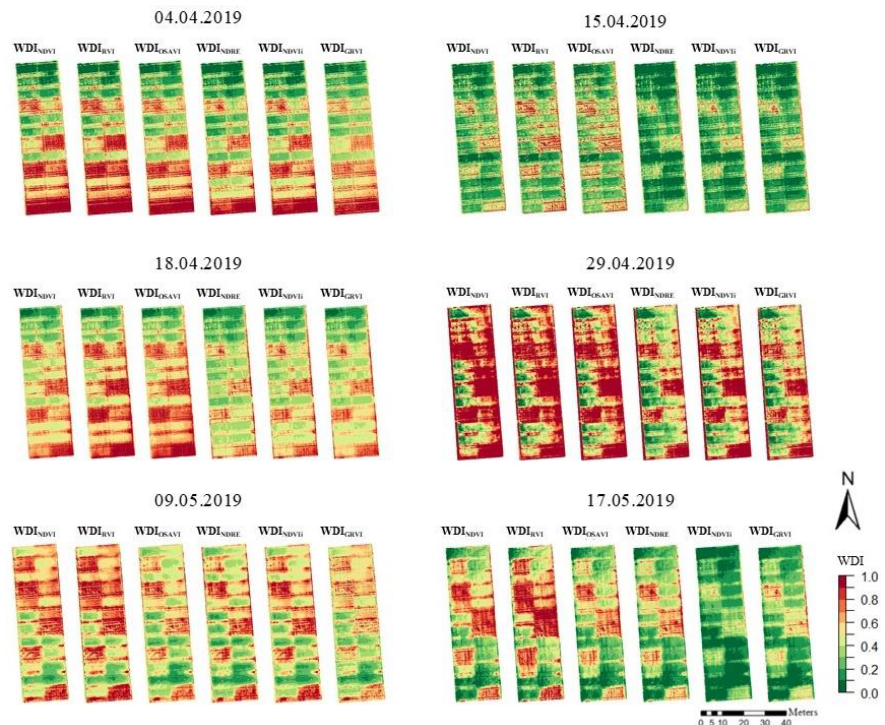
Figure A1. WDI maps calculated from different multispectral indices for the winter wheat growing season of 2019 (April–May).